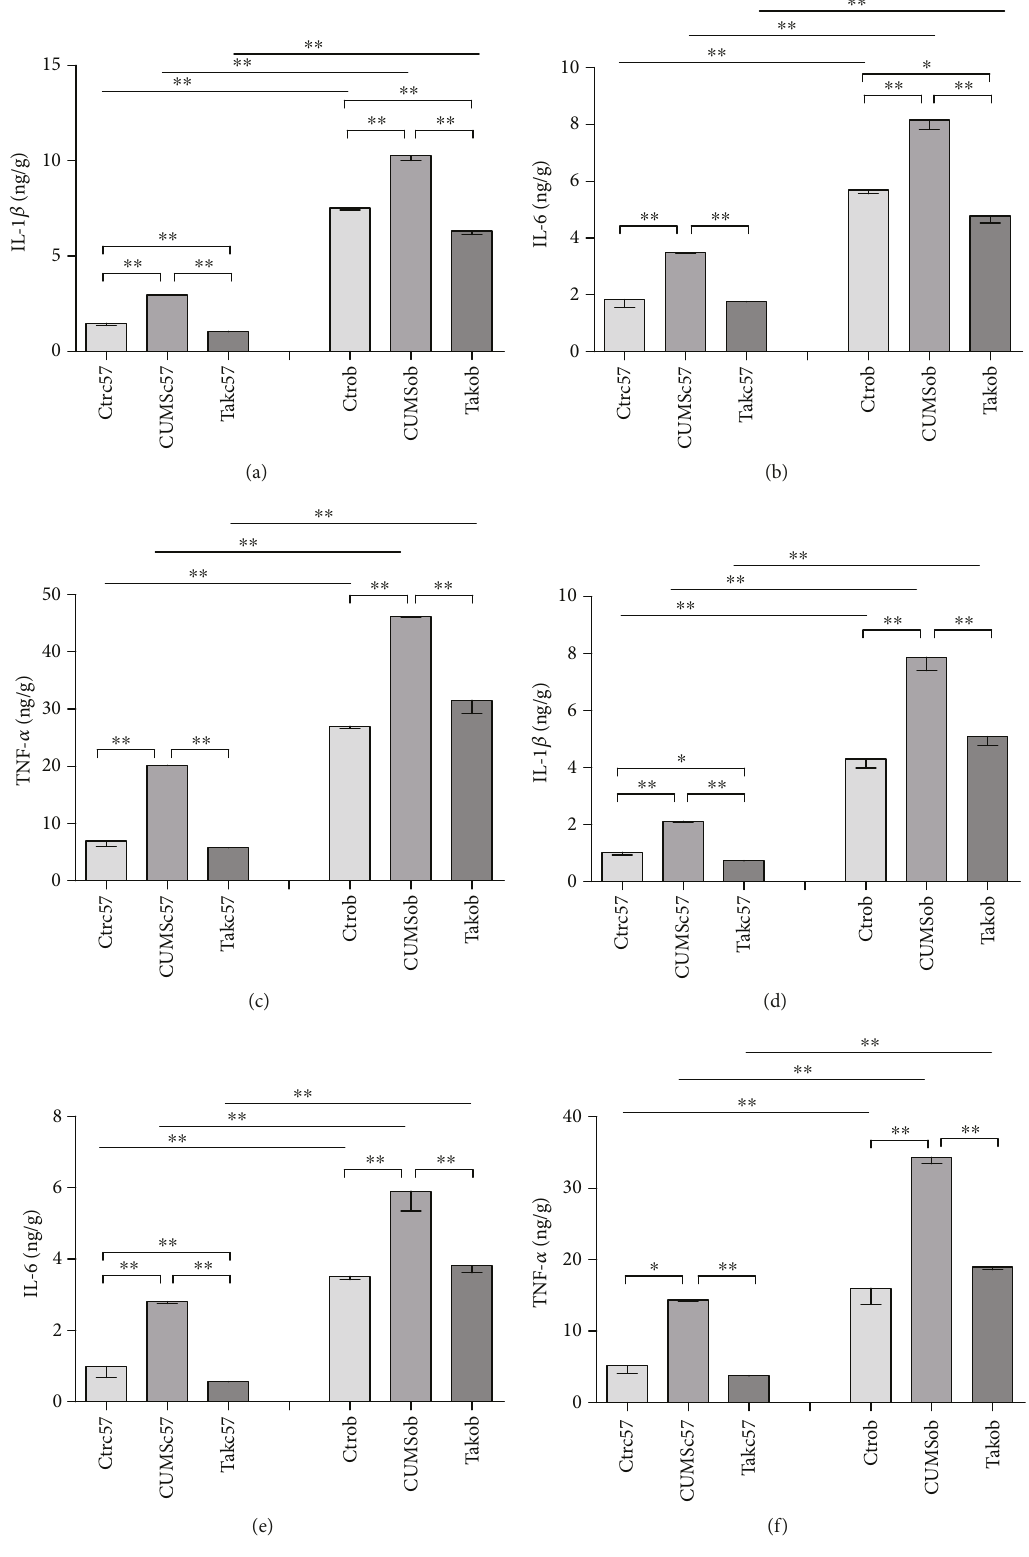
Figure 4: Cytokine expression in the frontal cortex and hippocampus measured in di ff erent groups: (a) IL-1 β expression in the frontal cortex; (b) IL-6 expression in the frontal cortex; (c) TNF- α expression in the frontal cortex; (d) IL-1 β expression in the hippocampus; (e) IL-6 expression in the hippocampus; (f) TNF- α expression in the hippocampus. Data are expressed as means ± SEM ( n = 6 in each group). ∗ p < 0 05 and ∗∗ p < 0 01